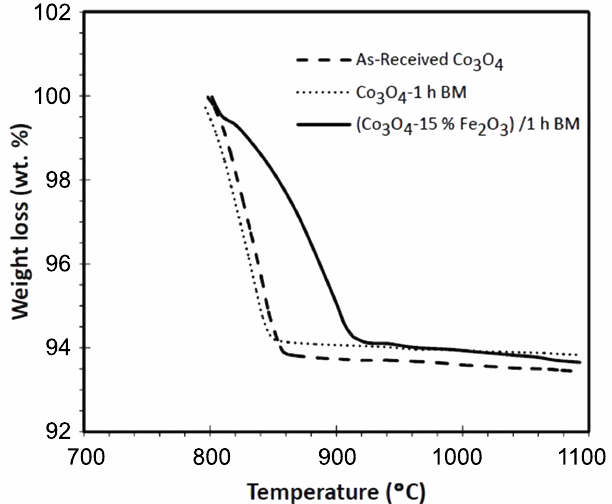
Fig. 5. TG curves of as-received Co 3 O 4 , 1 h ball milled Co 3 O 4 , and Co 3 O 4 -15 wt% Fe 2 O 3 /1 h